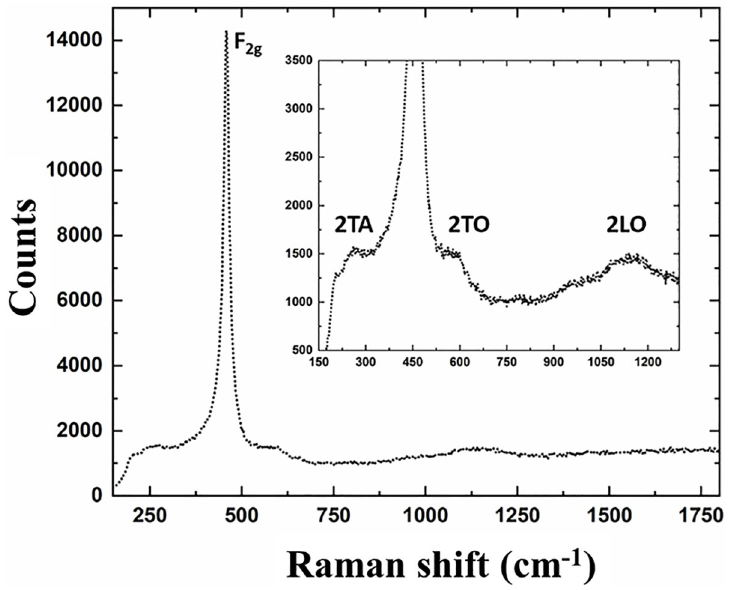
Fig 3. Raman spectroscopy for AgCNP. Prominent F 2g peak (465cm -1 ) characteristic of Ce-O-Ce breathing mode. Line broadening (FWHM: 20.74cm -1 ) is substantial and indicates low crystallite diameter (nanocrystalline features). 2TA (265 cm -1 ), 2TO (597 cm -1 ), and 2LO (1142 cm -1 ) second order Raman peaks emerge following chemical treatment and suggest surface/interfacial modification.